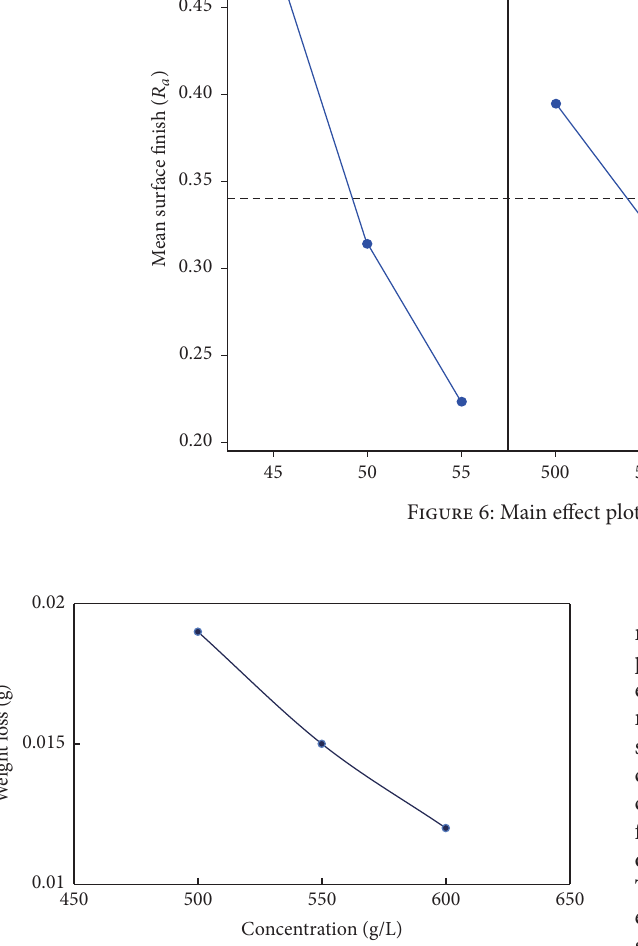
Figure 7: Graph of sample weight loss against concentration at 50 ∘ C and 20 Minutes of